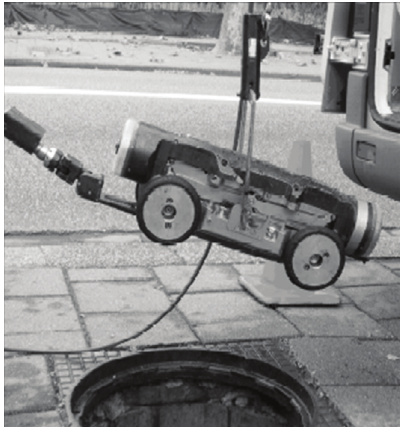
Figure 5: The PANORAMO system. (Source: http://www.werf.org/ AM/CustomSource/Downloads/uGetExecutiveSummary.cfm?FILE = ES-01-CTS-7.pdf&ContentFileID = 1960. Courtesy of